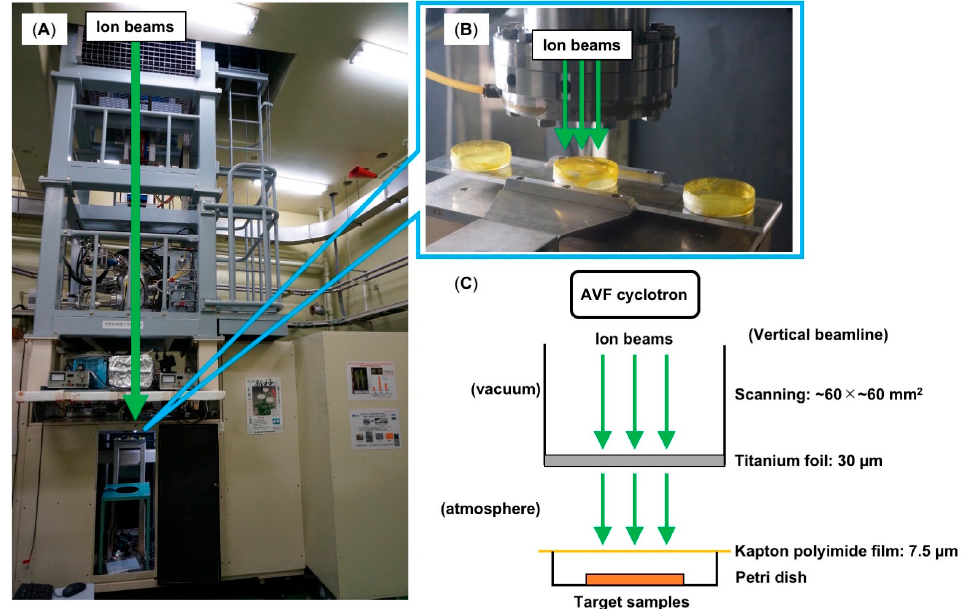
Figure 1. Outline of the ion beams irradiation. ( A ) Photo of the irradiation device for ion-beam breeding. ( B ) A magnified view of the irradiation area and target samples. ( C ) Schematic diagram of ion-beam irradiation. The ion beams were accelerated by the azimuthally varying field (AVF) cyclotron and transported to a vertical beamline. Next, the accelerated ion beams scanned the irradiation area (60 × 60 mm 2 ) uniformly in a vacuum chamber and exited through a 30-µm titanium foil to atmospheric conditions. Finally, the target microorganism samples were irradiated with ion beams at room temperature in the atmospheric conditions.